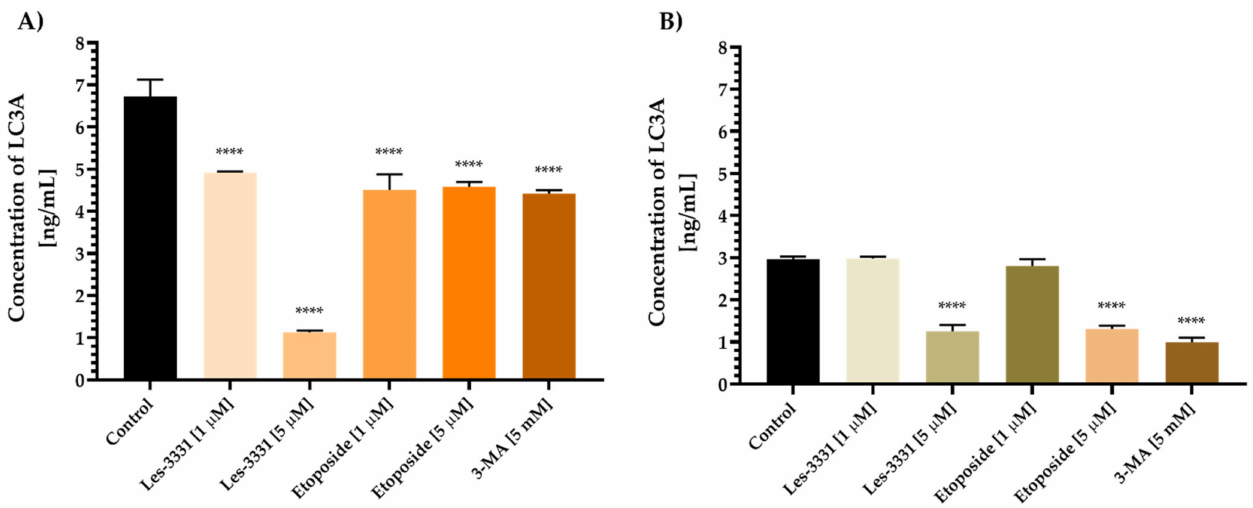
Figure 8. The concentration of LC3A in MCF-7 ( A ) and MDA-MB-231 ( B ) human breast cancer cells after 24 h incubation with Les-3331 and reference drug (etoposide) at 1 µ M and 5 µ M concentration. As a positive control, 3-Methyladenine (3-MA), a known autophagy inhibitor, in 5 mM concentration was used. Mean ± SD from three independent experiments performed in duplicate is presented. Statistical significance was calculated using one-way ANOVA with Bonferroni multiple comparison test. Differences were considered statistically significant at: **** ( p ≤